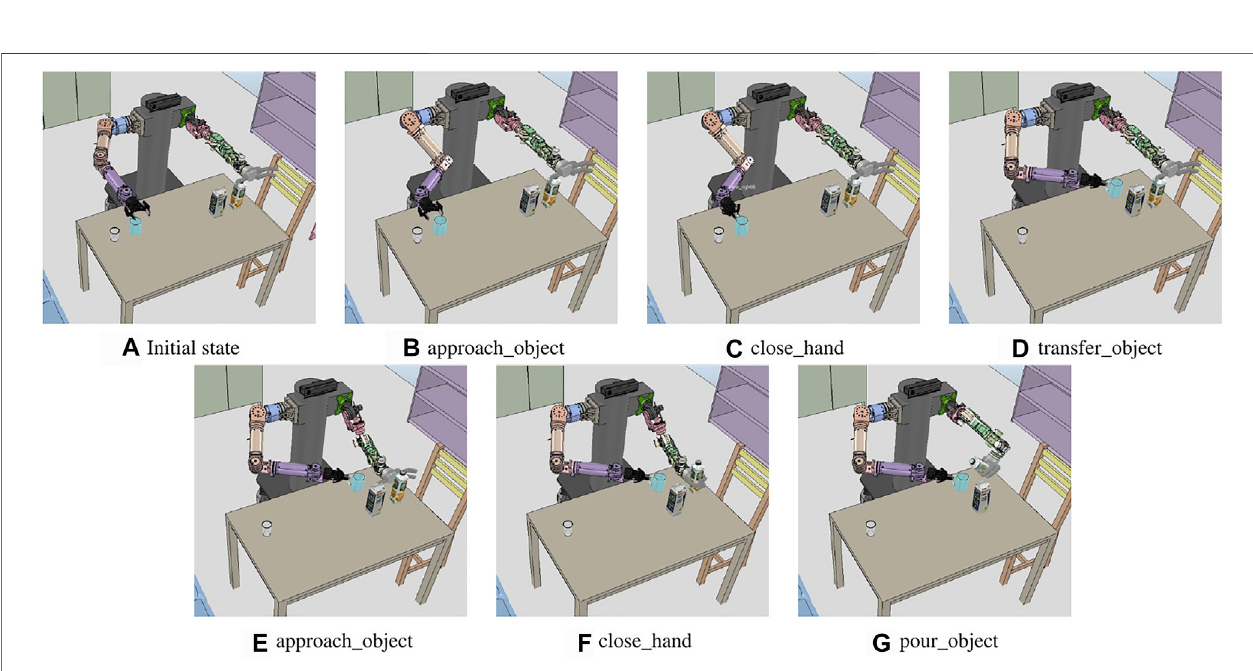
Frontiers in Robotics and AI |